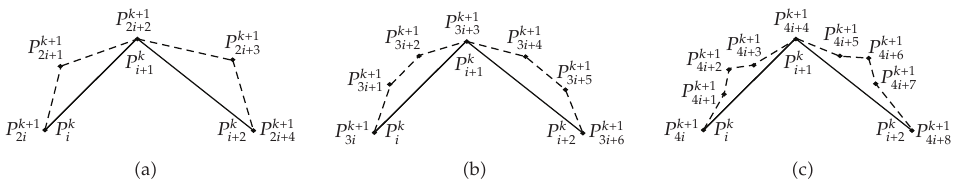
Figure 1: Solid lines show coarse polygons whereas doted lines are refined polygons. (cid:3) a (cid:4) – (cid:3) c (cid:4) represent binary, ternary, and quaternary refinement of coarse polygon of scheme (cid:3) 2.1 (cid:4) for n (cid:9) 2 , 3 , 4,